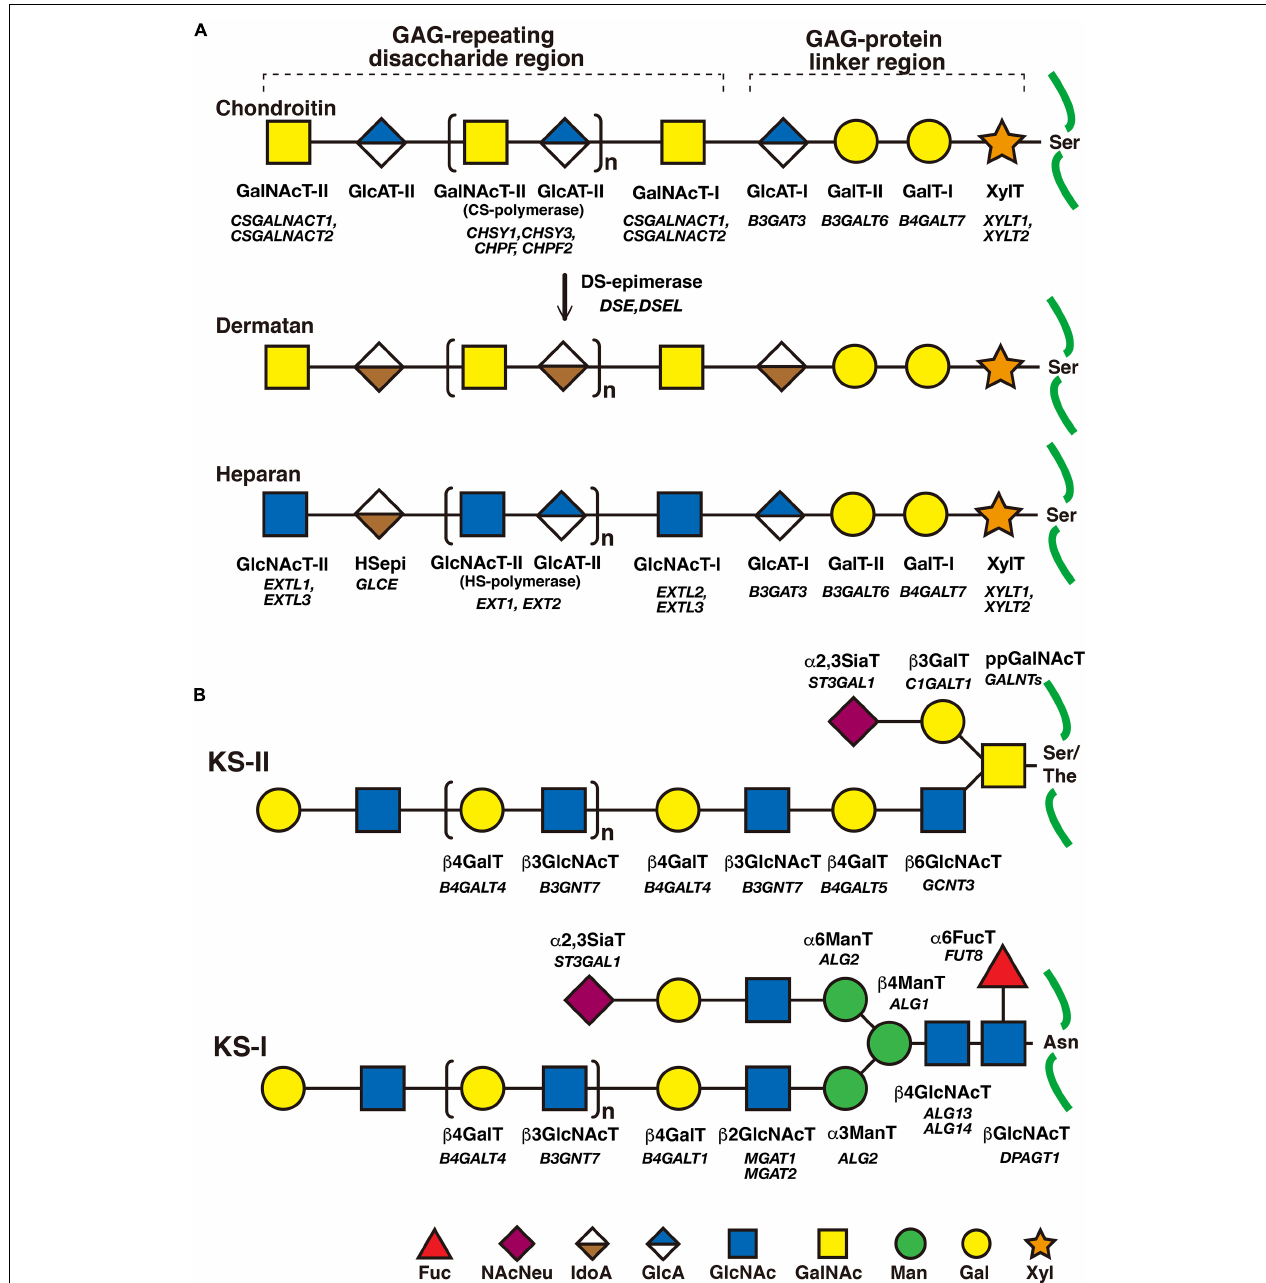
FIGURE 2 | The biosynthetic assembly of GAGs. (A) Schematic presentation of the biosynthesis of CS, DS, and HS. Following the synthesis of specific core proteins of proteoglycans, the common GAG-linker region tetrasaccharide (CS, DS, and HS except for KS), GlcA-Gal-Gal-Xyl- O -, is built up by the consecutive addition of each sugar moiety from the respective UDP-sugar, including UDP-Xyl, UDP-Gal, or UDP-GlcA, by XylT, GalT-I, GalT-II, and GlcAT-I. The first GalNAc residue is then transferred to the GlcA residue at the non-reducing end in the linker region by GalNAcT-I, which initiates the construction of the chondroitin backbone. The repeating disaccharide region (chondroitin backbone of CS), [-3GalNAc β 1–4GlcA β 1-] n , is elongated by alternate additions of GlcA and GalNAc residues from UDP-GlcA and UDP-GalNAc catalyzed by CS-GlcAT-II and GalNAcT-II activities, respectively. After or during the formation of the chondroitin backbone, DSE converts GlcA into IdoA by epimerizing the C-5 carboxy group, resulting in the formation of the dermatan backbone of DS, [-3GalNAc β 1–4IdoUA α 1-] n . Alternatively, the first GlcNAc residue is transferred to the GlcA residue at the non-reducing end in the linker region by GlcNAcT-I, which initiates the construction of the heparan backbone. The repeating disaccharide region (heparan backbone of HS), [-4GlcNAc α 1–4GlcA β 1-] n , is elongated by alternate additions of the GlcA and GlcNAc residues from UDP-GlcA and UDP-GlcNAc catalyzed by HS-GlcAT-II and GlcNAcT-II activities, respectively. (B) Schematic presentation of the biosynthesis of KS. After the formation of the linkage region of KS, O - and N -linked oligosaccharides, the repeating disaccharide region, [-4GlcNAc β 1–3Gal β 1-] n , is elongated by alternate additions of the Gal and GlcNAc residues from UDP-Gal and UDP-GlcNAc catalyzed by β 4GalT and β 3GlcNAcT activities, respectively. Each enzyme and its coding gene are described under the respective sugar symbols from the top of each